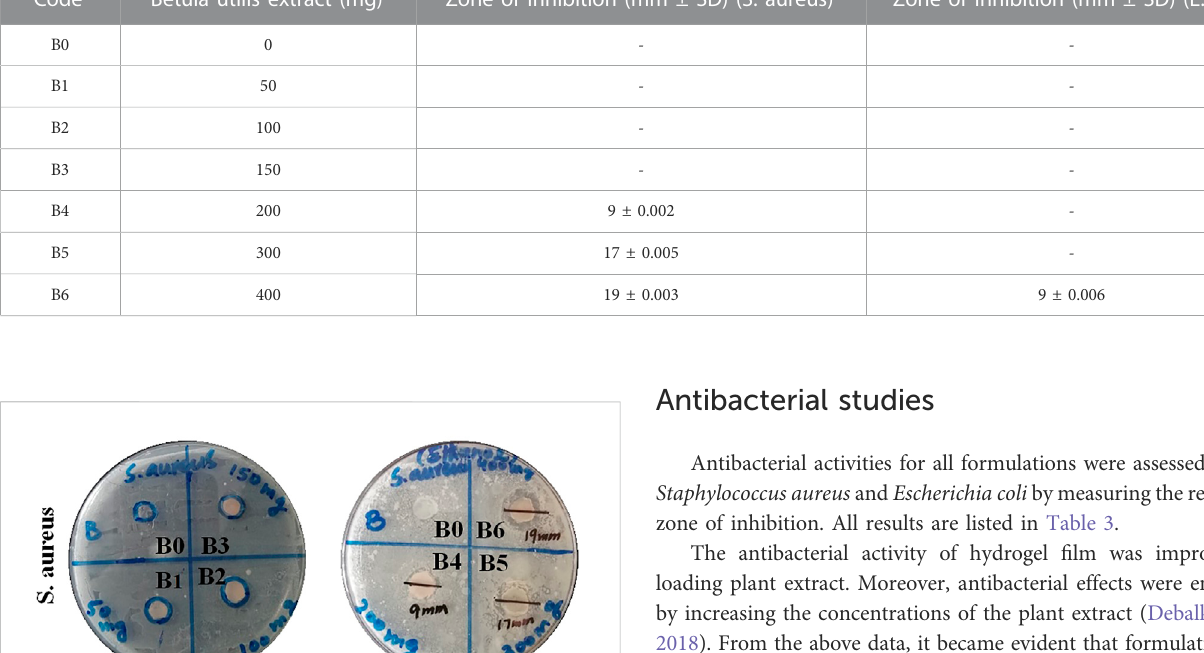
TABLE 3 Antibacterial activity of Betula utilis extract-loaded hydrogel fi lms (n = 3). Code Betula utilis extract (mg)